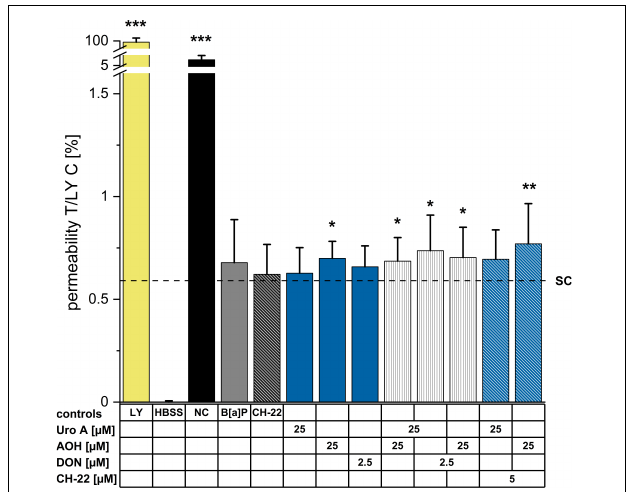
FIGURE 5 | Lucifer Yellow (LY) dye-assisted permeability measurements. Passage of LY through the differentiated Caco-2 monolayer was measured after 48 h of incubation (at least 3 biological replicates) by adding LY dye to the apical side of the monolayer for 1 h. LY (0.1 mg/mL in HBSS buffer), HBSS (blank), no cells (NC, passage through membrane only); Fluorescence of pure LY dye solution was set to 100%. Permeabilities as reported by fluorescent signals are presented as percentages. Statistical analysis was calculated applying two-sample Students’ t -test; significant differences are shown as * p < 0.05, ** p < 0.01, or *** p < 0.001 against the solvent control.